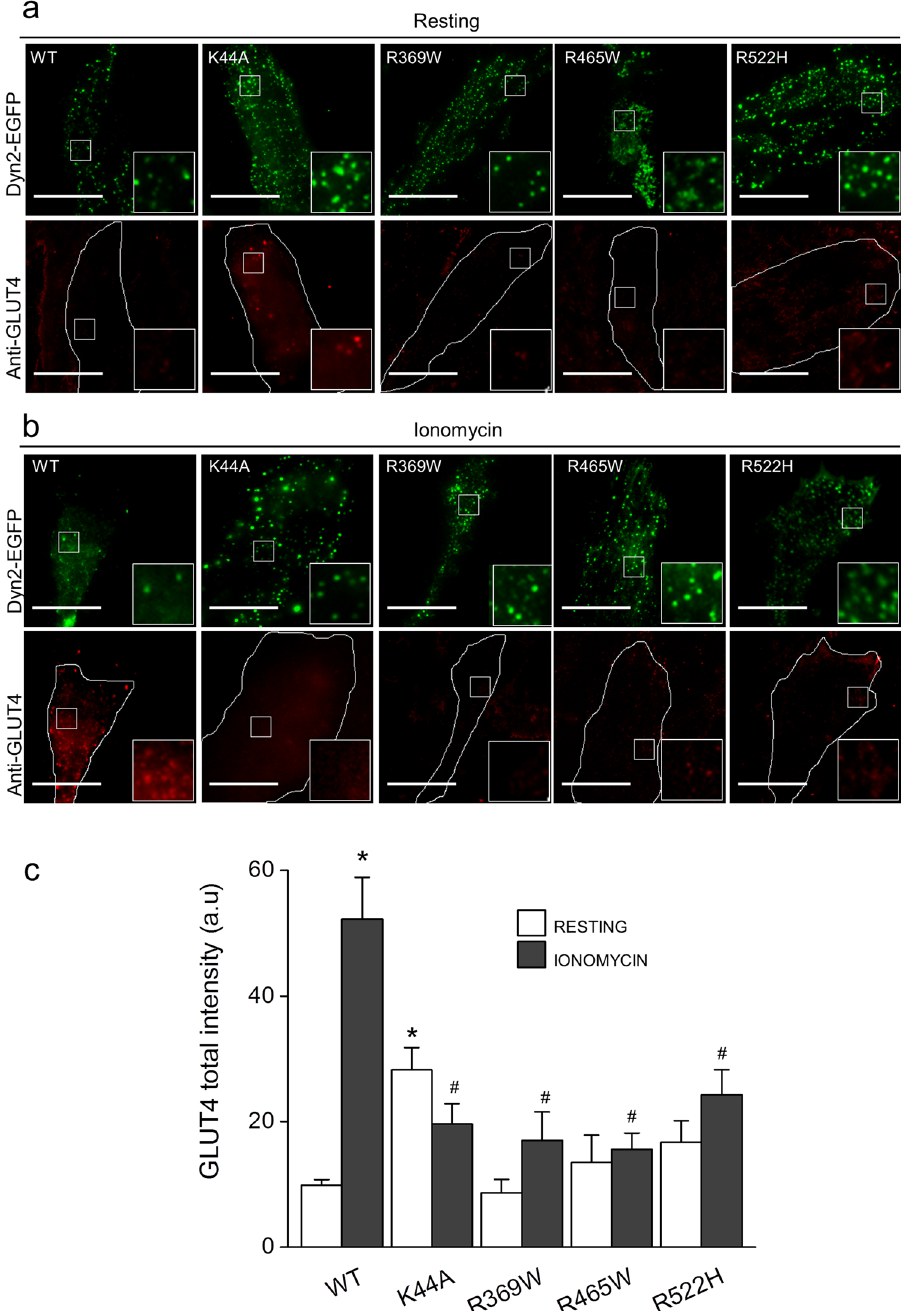
Figure 4. Dynamin-2-CNM-causing mutations reduce stimulus-induced translocation of endogenous GLUT4 in RCMH myoblasts. RCMH myoblasts were transfected with the dynamin-2 EGFP-fused constructs WT, K44A, R369W, R465W or R522H. 48 h later, transfected cells were stimulated with 20 μ M ionomycin during 5 min, fixed, immunolabeled with a monoclonal antibody directed against GLUT4 and visualized by TIRF microscopy. Plasma membrane insertion of endogenous GLUT4 was quantified as the total intensity fluorescence of GLUT4 in the evanescent field. ( a , b ) Examples of TIRF images (250 × 250 pixels) of RCMH myoblasts at the resting ( a ) and ionomycin-stimulated condition ( b ). Cell periphery is drawn in white in GLUT4 panels. ( c ) Quantification of GLUT4 total intensity fluorescence in the evanescent field. Note that cells expressing K44A mutant exhibit significantly higher levels of GLUT4 at the resting condition compared to resting-cells expressing Dyn2WT. Ionomycin increased GLUT4 signal in Dyn2WT-transfected cells but was not enough to increase GLUT4 signal in myoblasts expressing all the mutated versions of dynamin-2. Data are expressed as the mean GLUT4 total intensity fluorescence ± SEM. Statistical comparisons were performed utilizing a two-tail t-test Welch corrected for parametric data. The symbols * and # denote significance compared to Dyn2WT-transfected resting cells and Dyn2WT-transfected stimulated cells respectively. N is between 18 and 35 cells, from at least three different cultures per experimental